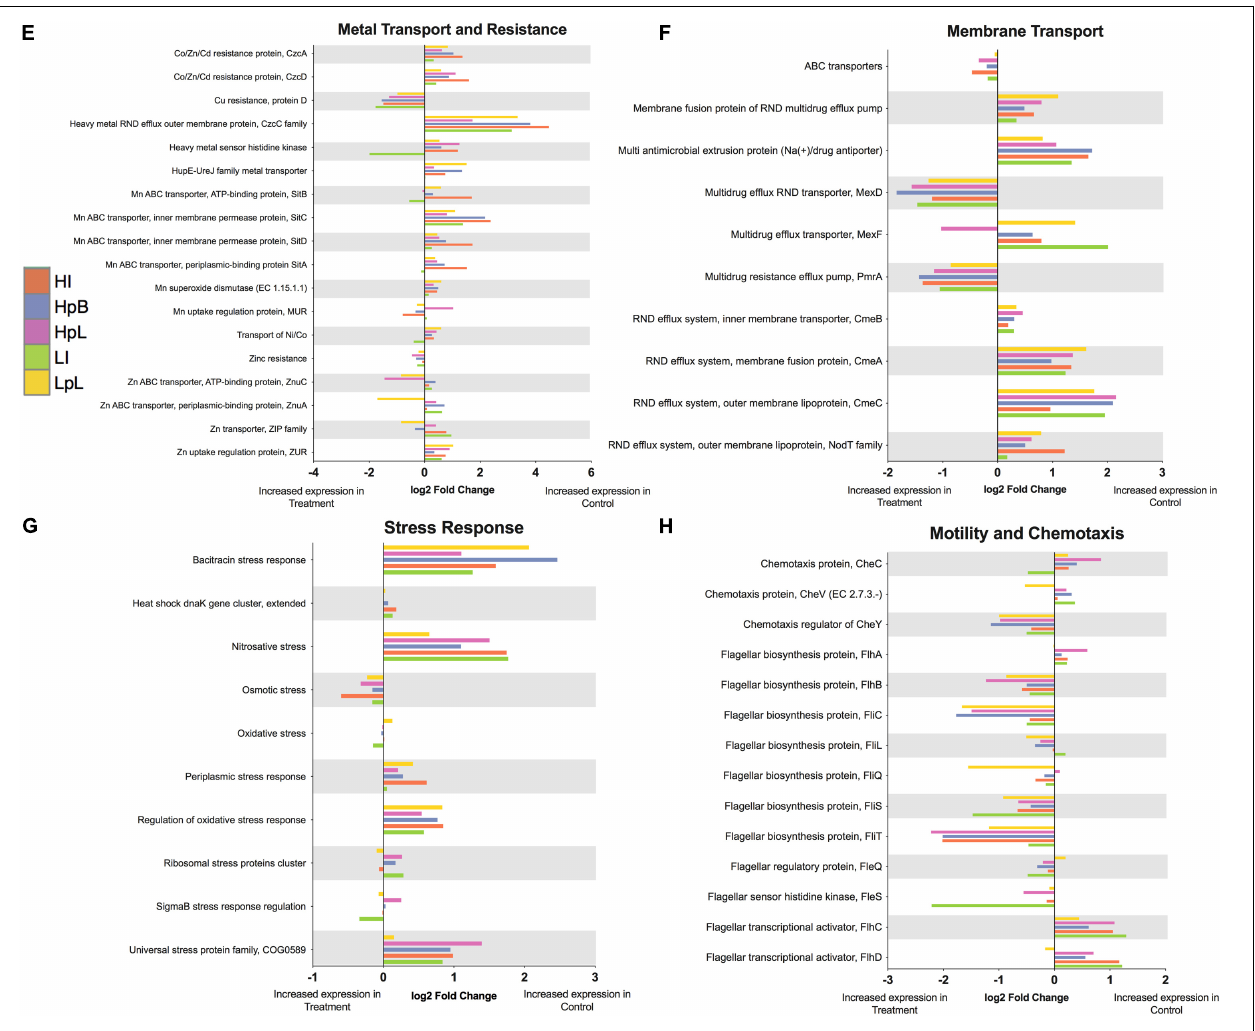
FIGURE 5 | (A–H) Differential expression (log2 fold change) of Levels 2, 3, and 4 SEED subsystems of interest to experimental Zn treatments relative to non-Zn-treated control biofilms.